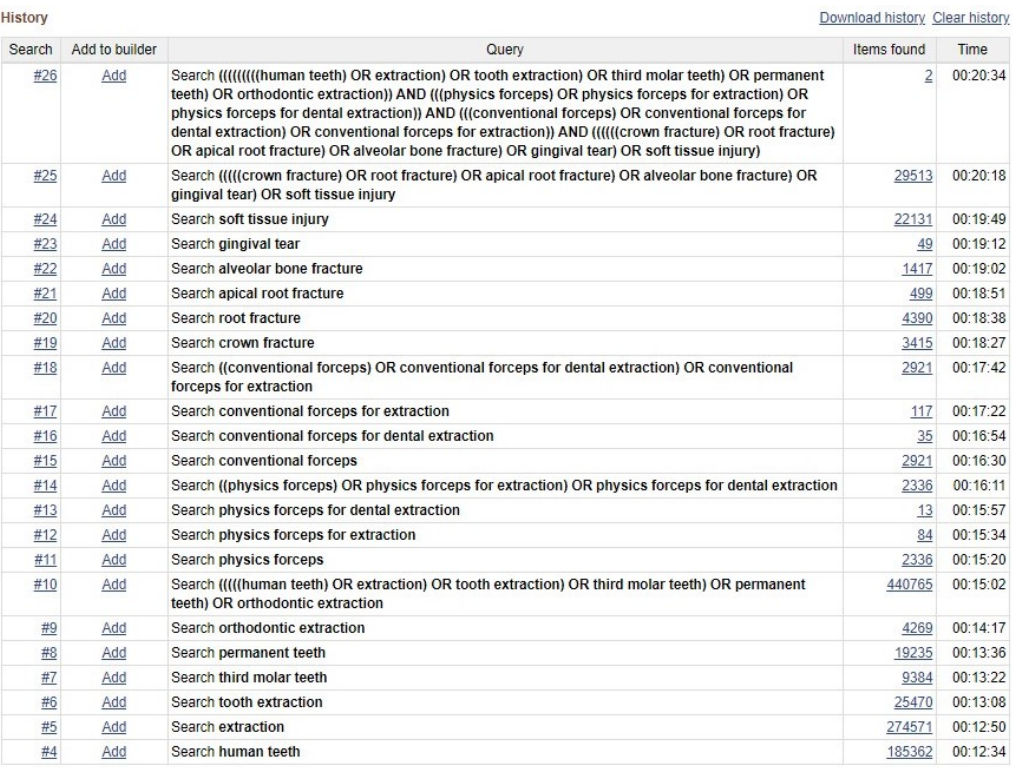
Figure 1. Search